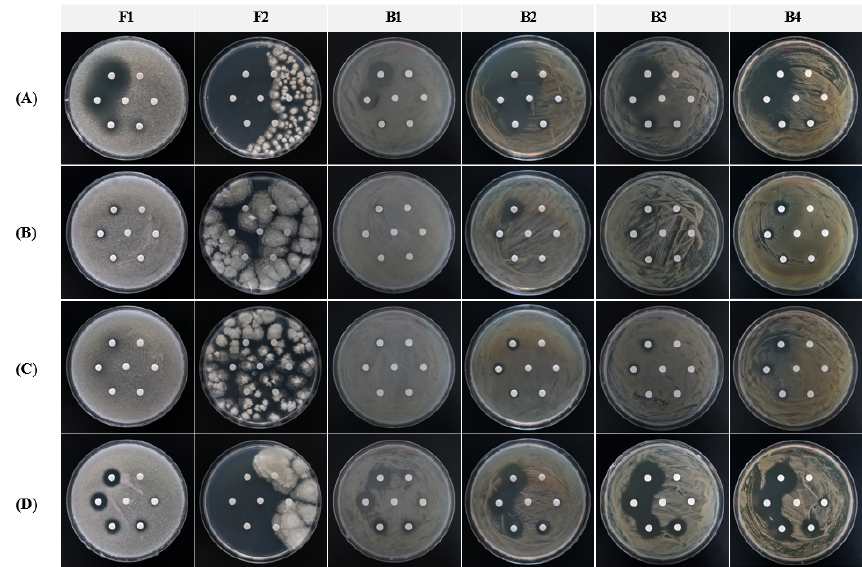
Figure 3. Evaluation of the antifungal and antibacterial activities of four essential oils at low concen- trations: ( A ) oregano EO, ( B ) clove bud EO, ( C ) thyme EO, ( D ) cinnamon cassia EO. The arrangement of the paper discs (and their respective EO concentrations) is presented in Figure 2B. Table 3. Effect of tested essential oils (low concentration) on microbial strains isolated from Buyeo Royal Tomb No. 1.